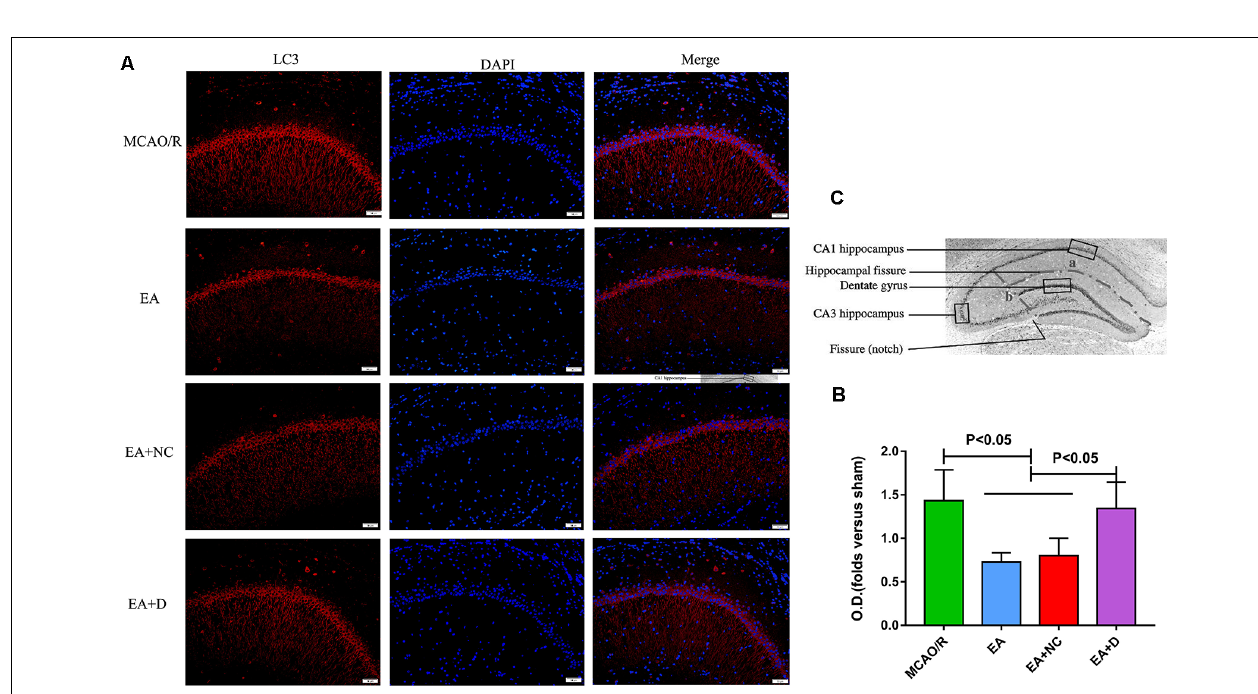
FIGURE 3 | IF analysis of the effect of EA treatment on autophagy-related proteins. (A) IF analysis showing the expression difference of LC3 in the ipsilateral hippocampus of the rats. (B) Statistical analysis of the LC3 expression assessed by IF. (C) The anatomical illustration of the hippocampus in the rat.